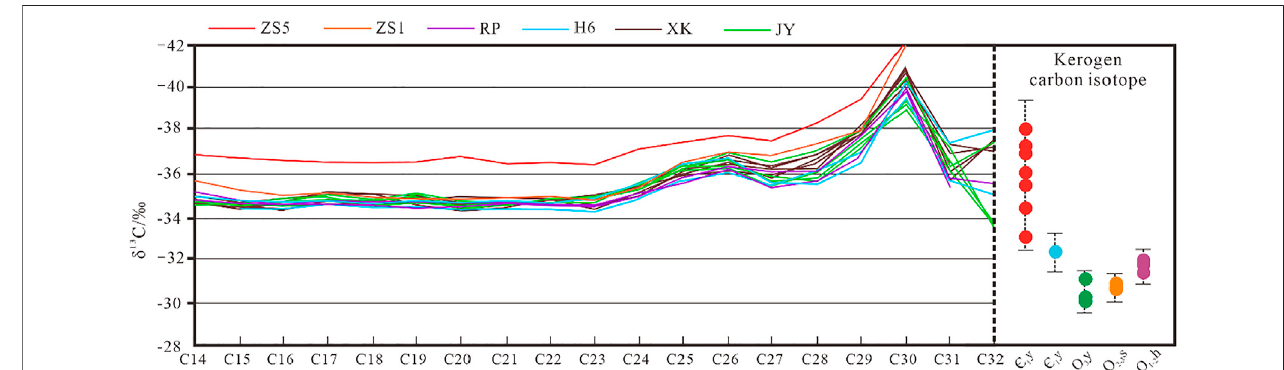
FIGURE 15 | Distribution characteristics of δ 13C1- δ 13C2- δ 13C3 of Ordovician natural gas in the Halahatang Area.